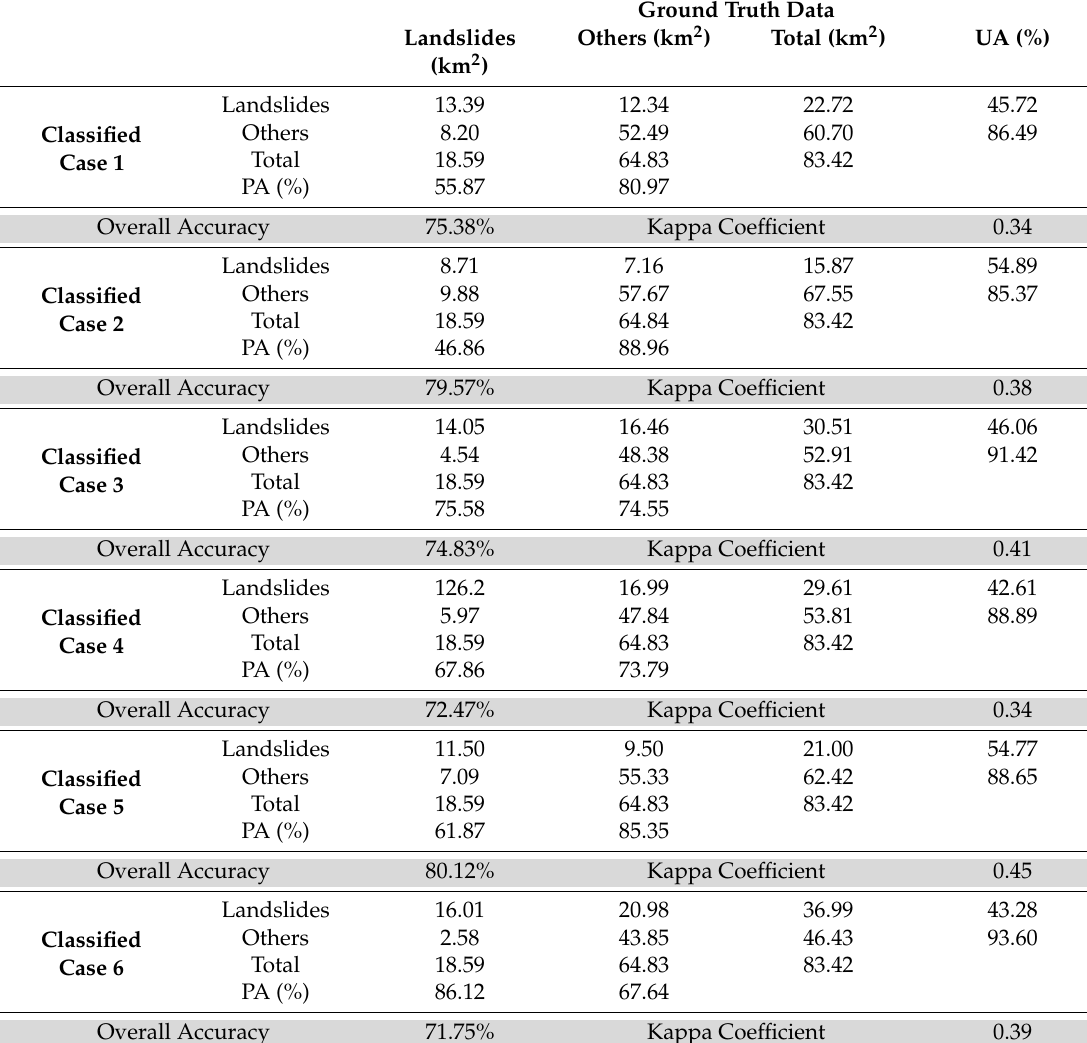
Table 2. The results of accuracy assessment of landslide classifications (case 1-6). UA and PA refer to the user’s and producer’s accuracies,